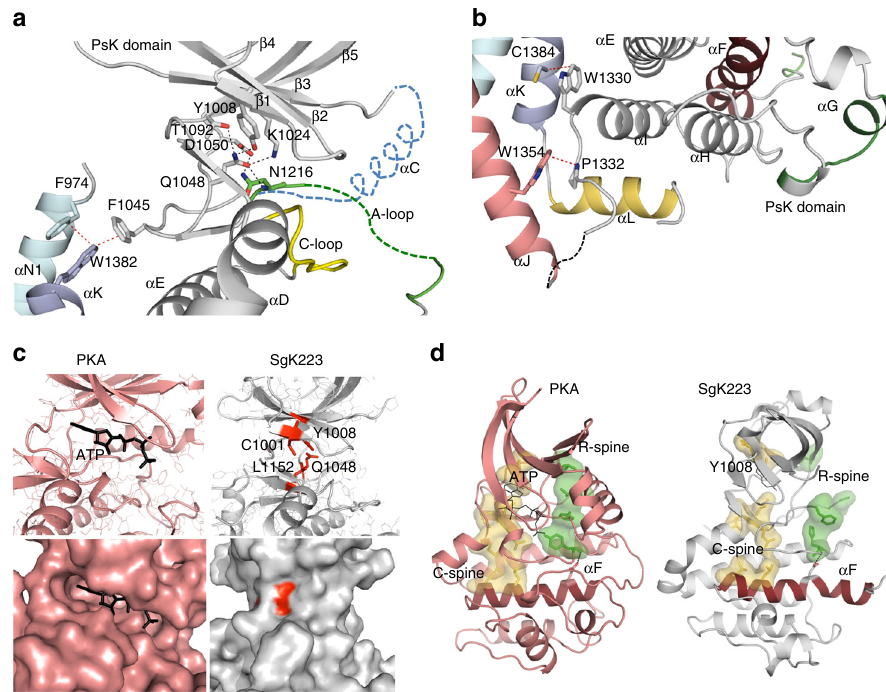
Fig. 2 The unique features of SgK223 PsK domain. a Interaction between N-lobe of the PsK domain and the dimerization domain. b Interaction between the C-lobe of the PsK domain and the dimerization domain. α N1, cyan; PsK domain, grey; α J, salmon; α K violet; α L yellow; A-loop, green; C-loop, yellow; α C is modelled in blue dashed lines. c Comparison of the nucleotide binding site of PKA (left) and SgK223 (right). PKA, salmon; ATP, black; SgK223, grey, residues occupying the ATP-binding sites shown in red. d Location of C- and R-spines on PKA and SgK223. C-spine, yellow; R-spine, green; α F, dark